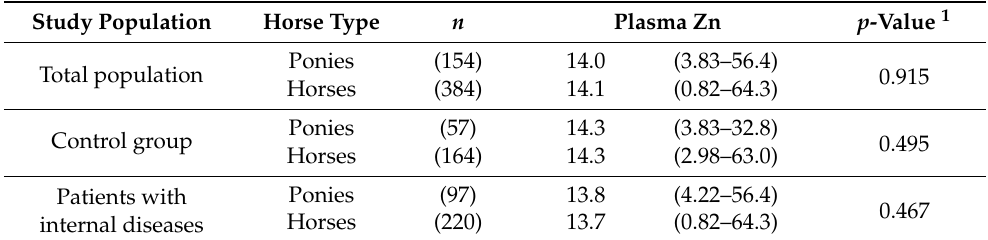
Table 4. Plasma Zn concentrations ( µ mol/L) of the hospitalized horses and ponies, depending on the horse type. Median